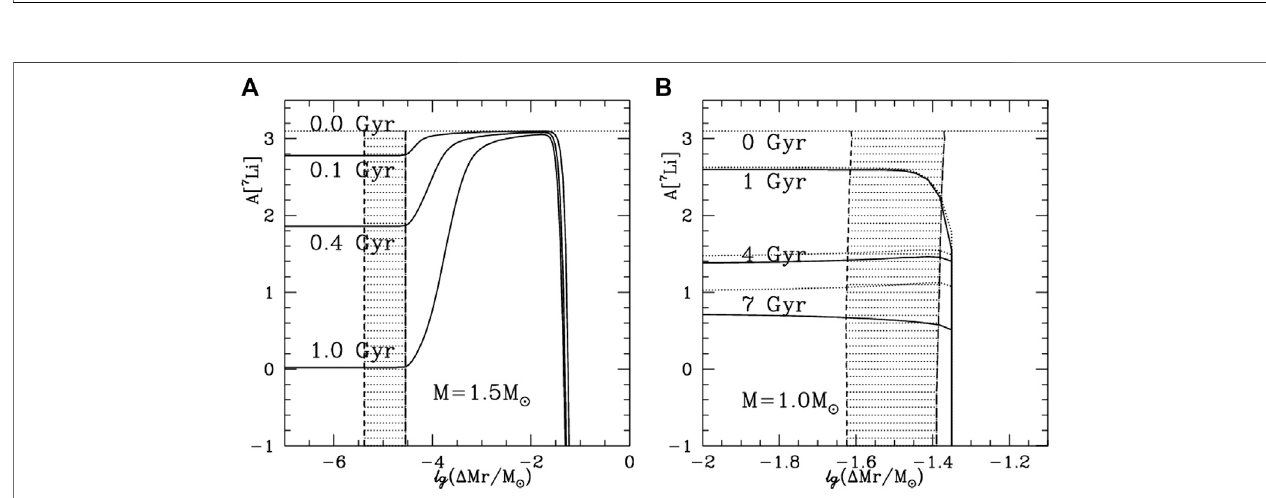
FIGURE10| Lithiumabundancesasafunctionofdepthlog ( Δ M r / M ) attheagesindicatedonthecurvesfor1 . 5M ⊙ (A) ,and1 . 0M ⊙ (B) stars,where Δ M r (cid:1) M − M r , and M and M r are, respectively,the total massand masswithinradius r. M ⊙ isthesolarmass.The shaded areas mark theovershootingzone ineach panel, boundedby the dashed line (left) and long dashed line (right). The dotted lines are for the theoretical model with only overshooting mixing, and the solid lines are for the theoretical model with both overshooting mixing and gravitational